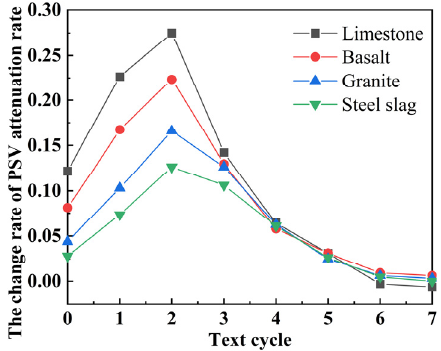
Figure 3. PSV attenuation curves.